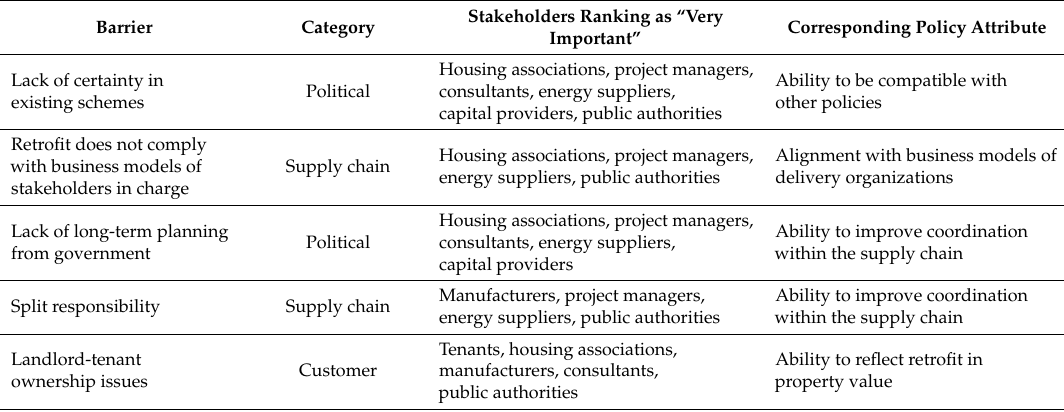
Table 4. Perceived importance of retrofit barriers across stakeholder